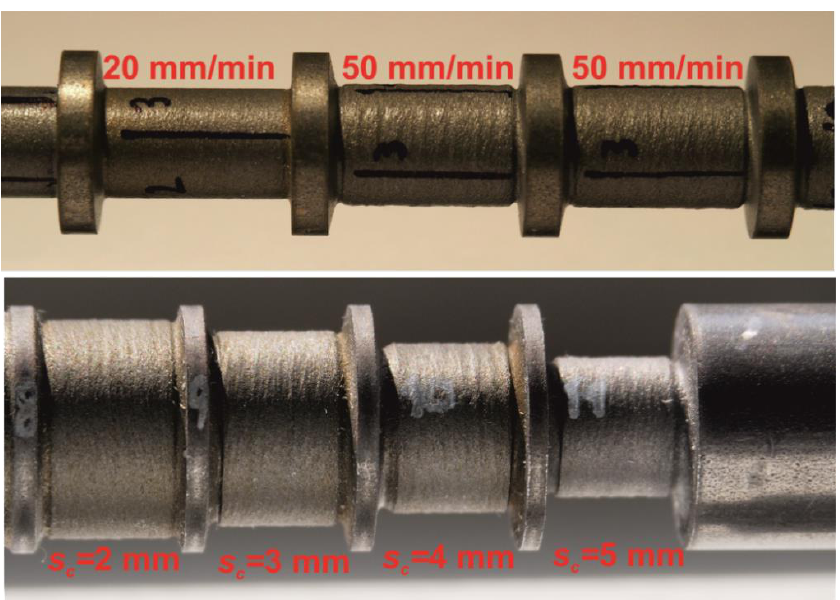
Figure 10. Comparison of the surface quality for two traverse speeds and several cumulative lateral jet shifts.